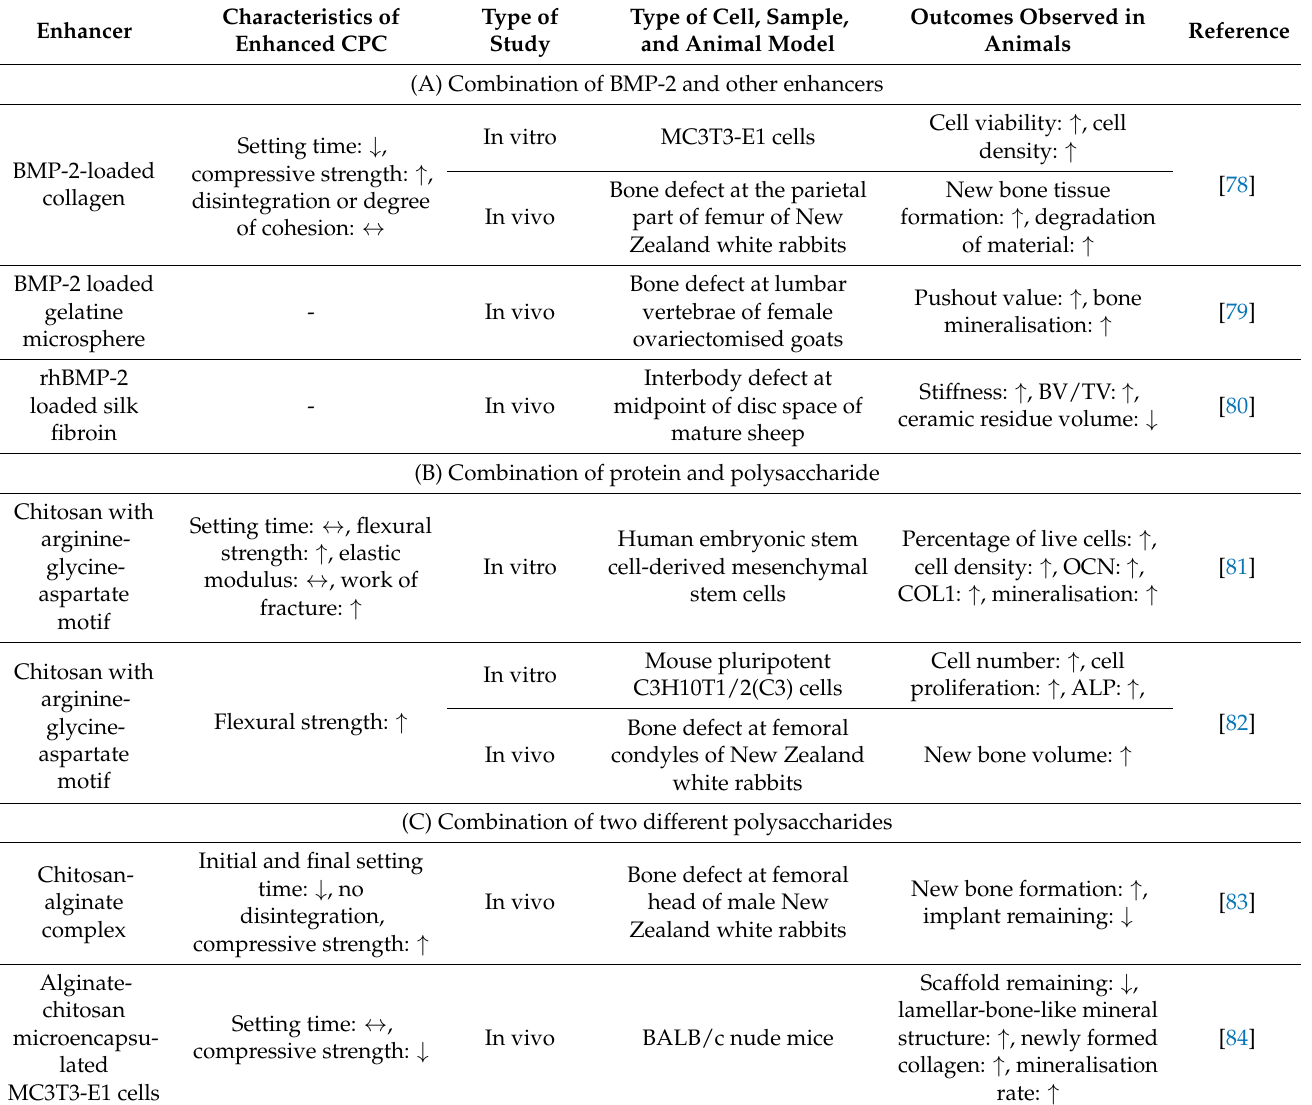
CPC containing BMP-2 loaded gelatine microspheres. The implanted vertebral bone of the animals had greater mechanical strength and bone mineralisation rate after 45 days than the untreated group [79]. In the ovine model of interbody defect created at the midpoint of disc space, the site filled with CPC/silk fibroin/rhBMP-2 composite exhibited higher stiffness and bone volume, which were on par with those implanted with autograft. Lower material residue volume was also detected in CPC reinforced with silk fibroin and rhBMP-2 compared to the material without rhBMP-2 [80]. Table 6. The bone protecting effects of CPC enhanced by the combination of biological enhancers. Characteristics of Type of Type of Cell, Sample, Outcomes Observed in Enhancer Enhanced CPC Study and Animal Model Animals